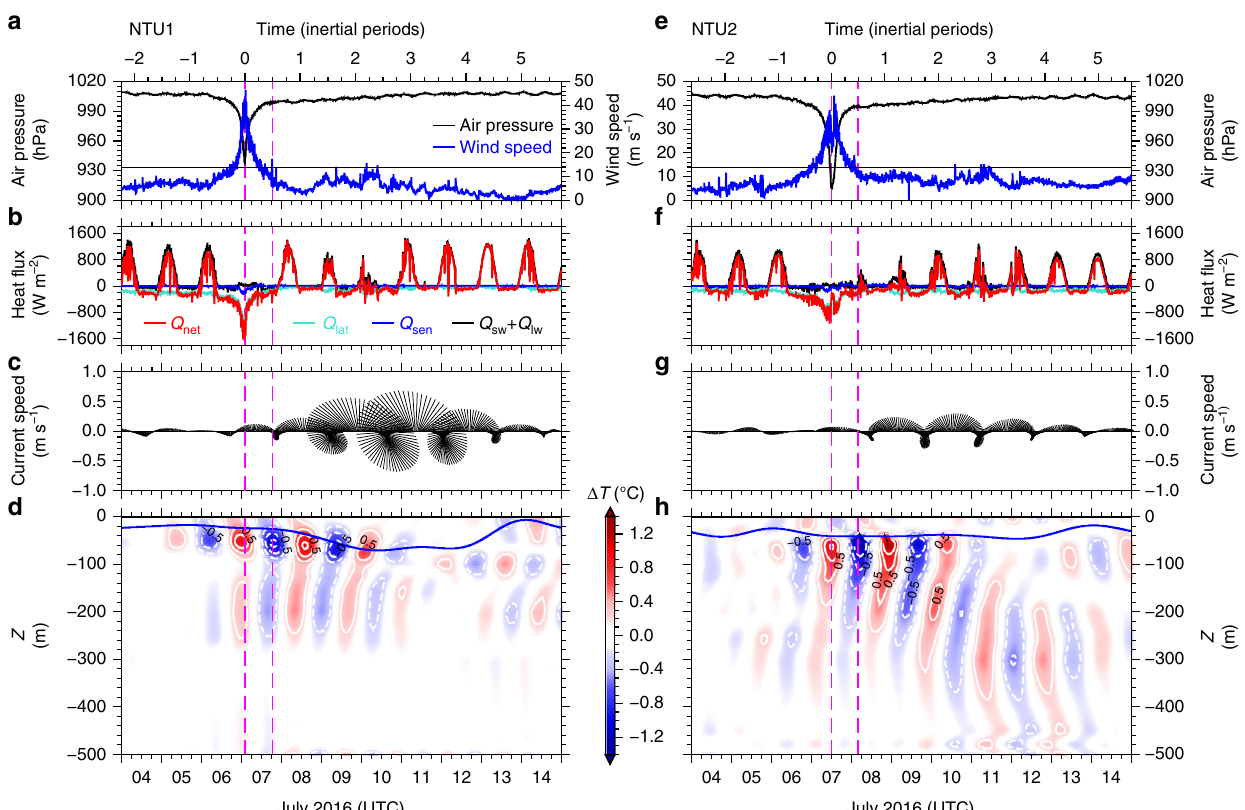
Fig. 3 Buoy observed atmosphere and ocean variables at NTU1 and NTU2 during 4 – 14 July 2016. a , e Air pressure (black line) and wind speed (blue line), with the top axis indicates time in inertial periods and the wind speed 13.9 m s − 1 (equivalent to 50 km h − 1 or a Beaufort scale 7) indicated by the black horizontal line. b , f Buoy data-derived net air – sea heat fl ux ( Q net ), net radiation ( Q sw + Q lw ), latent heat fl ux ( Q lat ), and sensible heat fl ux ( Q sen ). c , g Observed velocity-derived 75 m depth inertial-band (periods from 28.07 to 49.3 h) velocity sticks. d , h Inertial-band temperature anomalies in the upper 500 m (color shading) and the mixed layer depth (blue lines). The two magenta vertical dashed lines indicate the time at a minimum air pressure (left) and after the 0.5 local inertial period